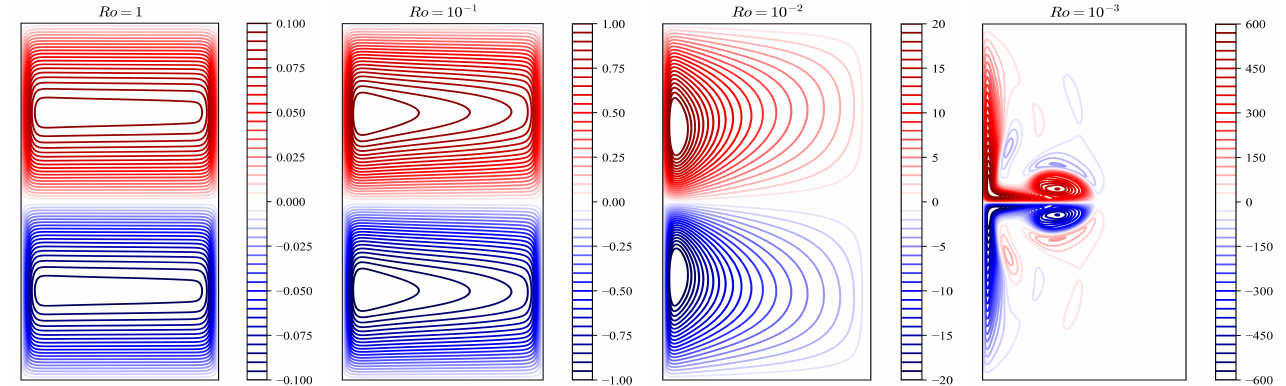
Figure 1. Solutions (vorticities) of the QGE subject to different Rossby numbers on the rectangular domain [ 0,1 ] × [ 0,2 ] when Re = 100 and F e = sin ( π ( y − 1 )) at t = 0.1. From left to right: Ro = 1,0.1, 0.01, and 0.001. It is seen that decreasing the Rossby number yields a sharper western boundary